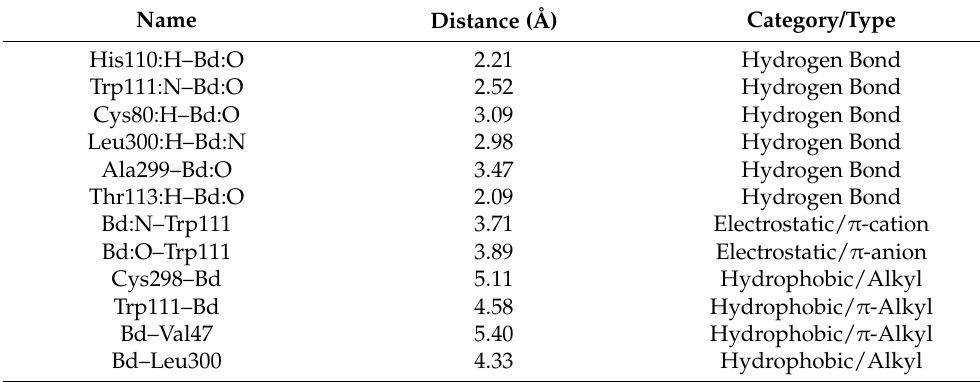
Table 6. Interactions between the deprotonated Bd (C17C15C2-COOH) and the receptor pocket.